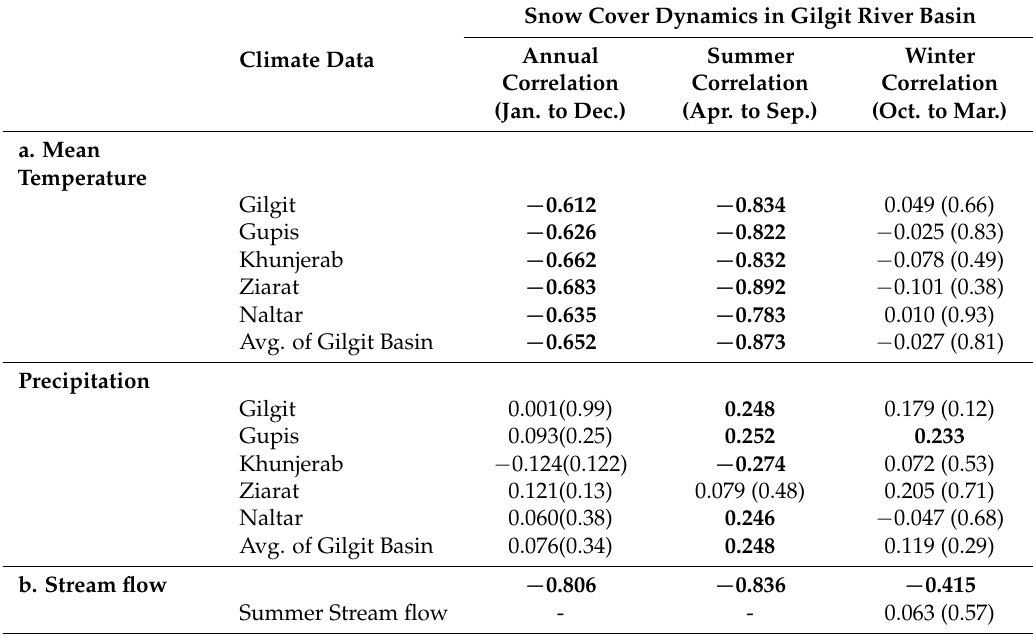
Table 3. Annual and seasonal correlation coefficients between snow cover area, Gilgit River basin (2001–2013); ( a ) monthly climate data (temperature and precipitation) in the Gilgit Basin climate stations (2001–2013), and ( b ) stream flow at Alam Bridge.